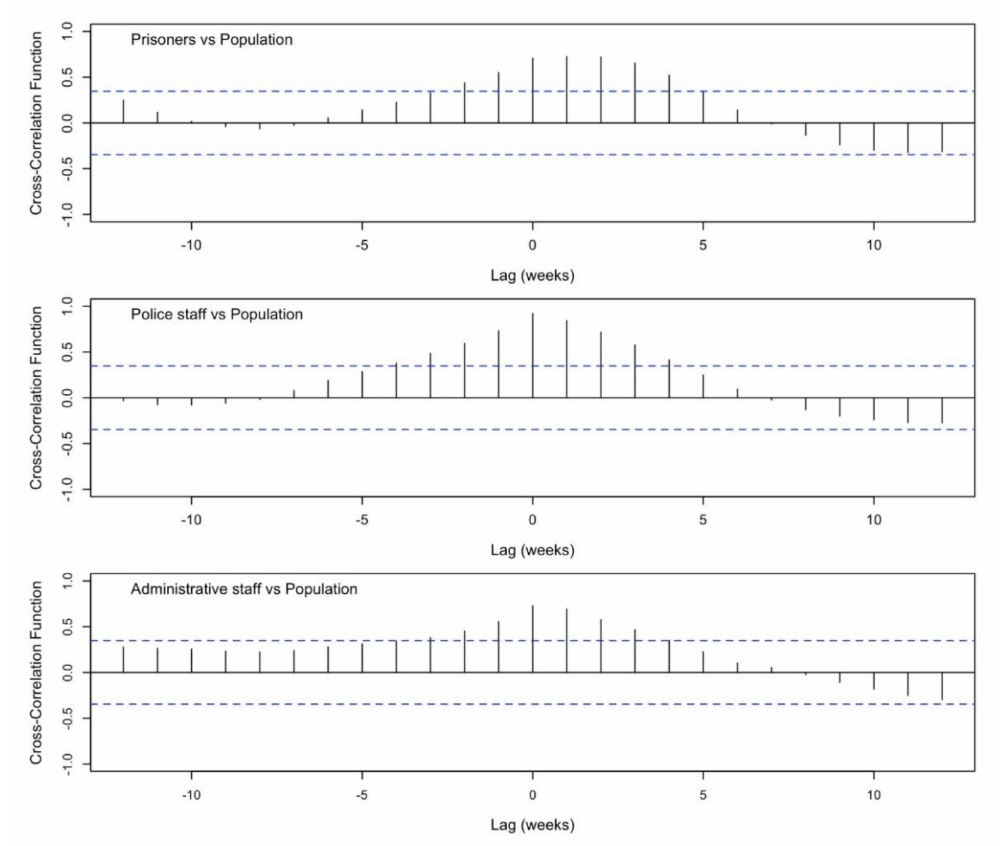
Figure 3. Cross correlation analysis of the time lags between the examined populations. Table 2. Confirmed cases among prisoners and prison